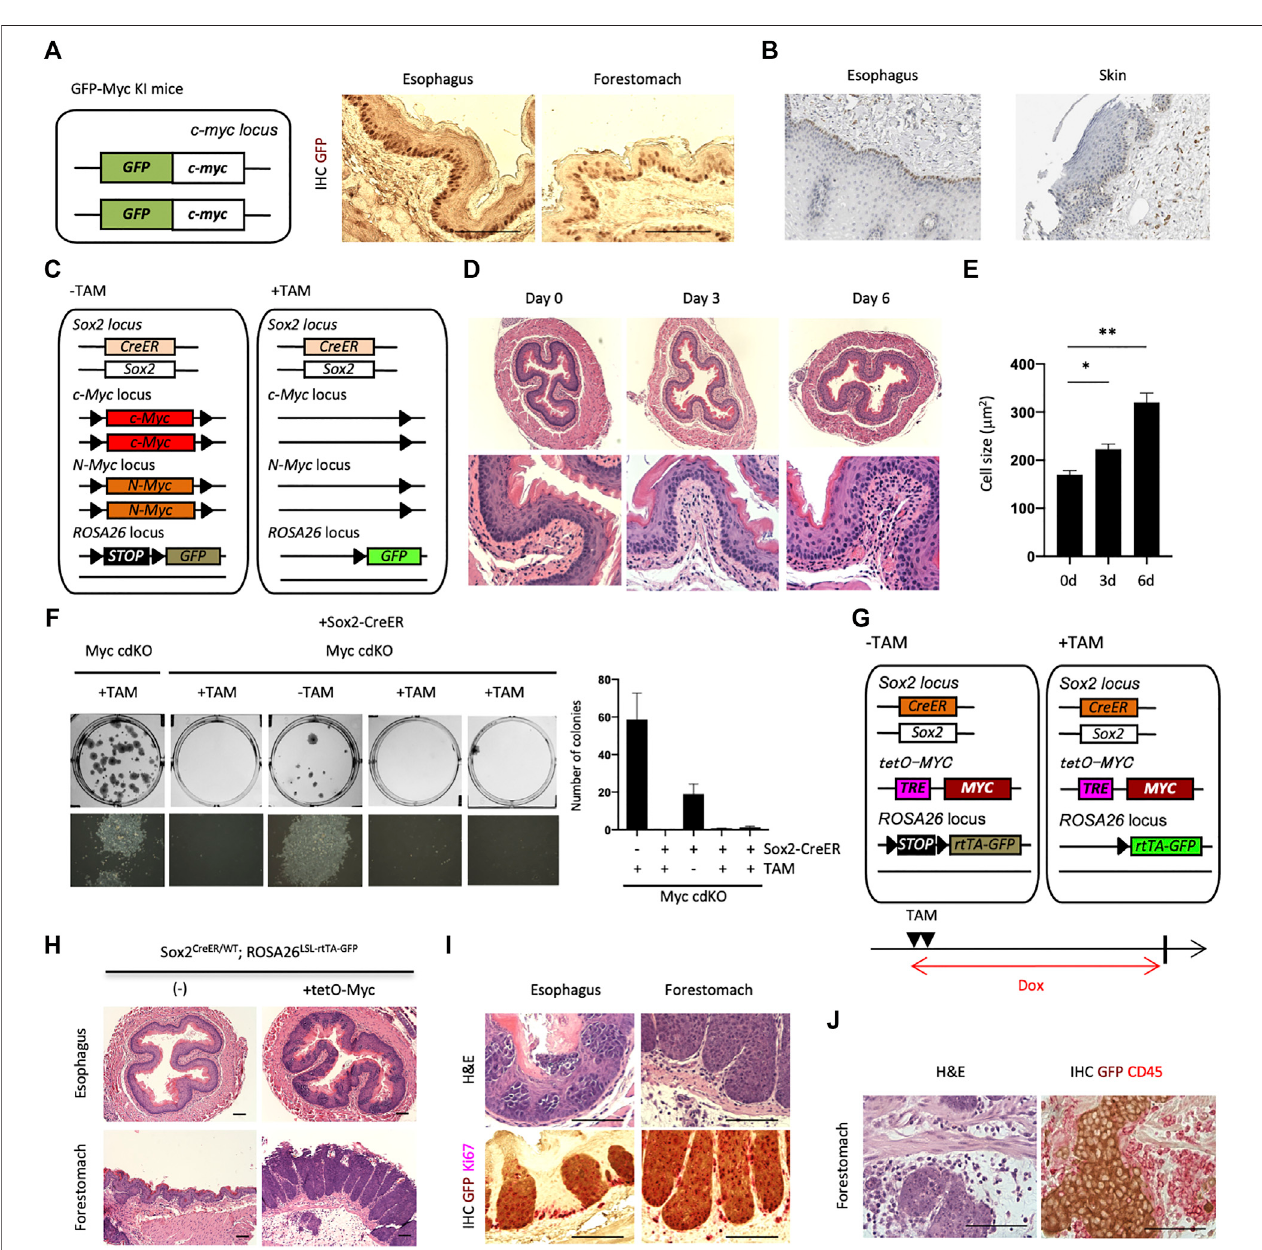
FIGURE 2 | Loss-of-function and gain-of-function of Myc in the esophagus. (A) IHC for GFP on paraf fi n-embedded sections of the esophagus and forestomach from GFP-Myc Knock-in (KI) mice. Scale bars, 100 μ m. Two mice were analyzed. (B) IHC image of MYC staining for the human esophagus and skin. MYC is largely expressed in esophageal basal layer. The data were kindly provided by the Protein Atlas Project publicly available (www.proteinatlas.org). (C) Schematic representation ofSox2 + cell-speci fi cMyc conditionaldouble knockout mice, Sox2 CreER/WT ; cMyc Flox/Flox ; nMyc Flox/Flox ; ROSA LSL-GFP/WT (MyccdKO). GFPcan be used forlineage tracing purpose. (D) H&E staining for esophagi from Myc cdKO mice treated with TAM. Two mice were analyzed for each condition. (E) Cell size of esophageal basal cells.Twomicewereusedforeachcondition.DatarepresentthemeanwithSE.* p < 0.05,** p < 0.0001. (F) Clonogeniccolony-formingassays.Aftercellisolation,2,500 live cells were seeded per well in 6-well plate in ADCY medium. Twelve days after seeding, the cells were stained with Leishman ’ s stain to count the number of colonies. Each culture was derived from each indicated mice. Left, representative image of each condition. Right, quanti fi cation of colony number. Data represent the mean with SD ( n = 3). (G) Schematic representation of Sox2 CreER/WT ; tetO-MYC ; ROSA LSL-rtTA-GFP/LSL-Luc mouse. TAM treatment eliminates STOP cassette in front of rtTA-IRES- GFP in ROSA26 locus, which can activate transgenic MYC expression in a tetracycline- or doxycycline (Dox)-dependent manner. GFP expression allows for lineage tracing.Themicewerecollected10 daysafter2-daysTAMtreatment.Doxwasadministeredtothemiceintheirdrinkingwater(0.5 mg/ml). (H,I) H&E (H) andIHCs (I) on paraf fi n-embedded sections of the indicated tissues corrected from SMP WT/WT . Three mice were analyzed. Scale bars, 100 μ m. (J) In fl ammation along with tumor invasion in forestomach. Scale bars, 100 μ m.